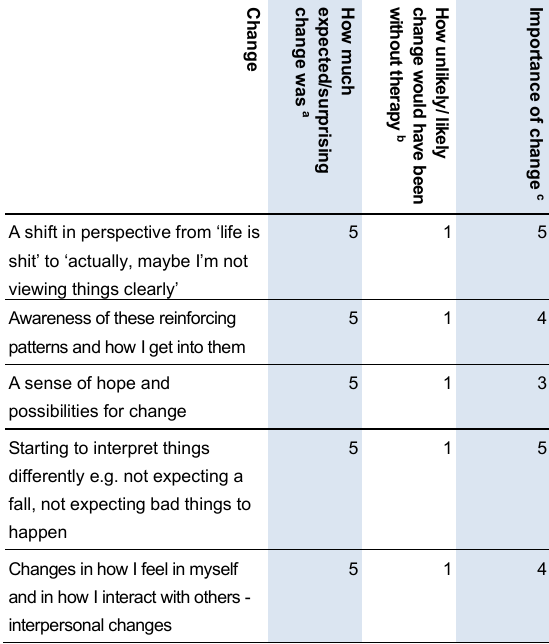
Table 2. Peter’s changes as identified in post-therapy Change